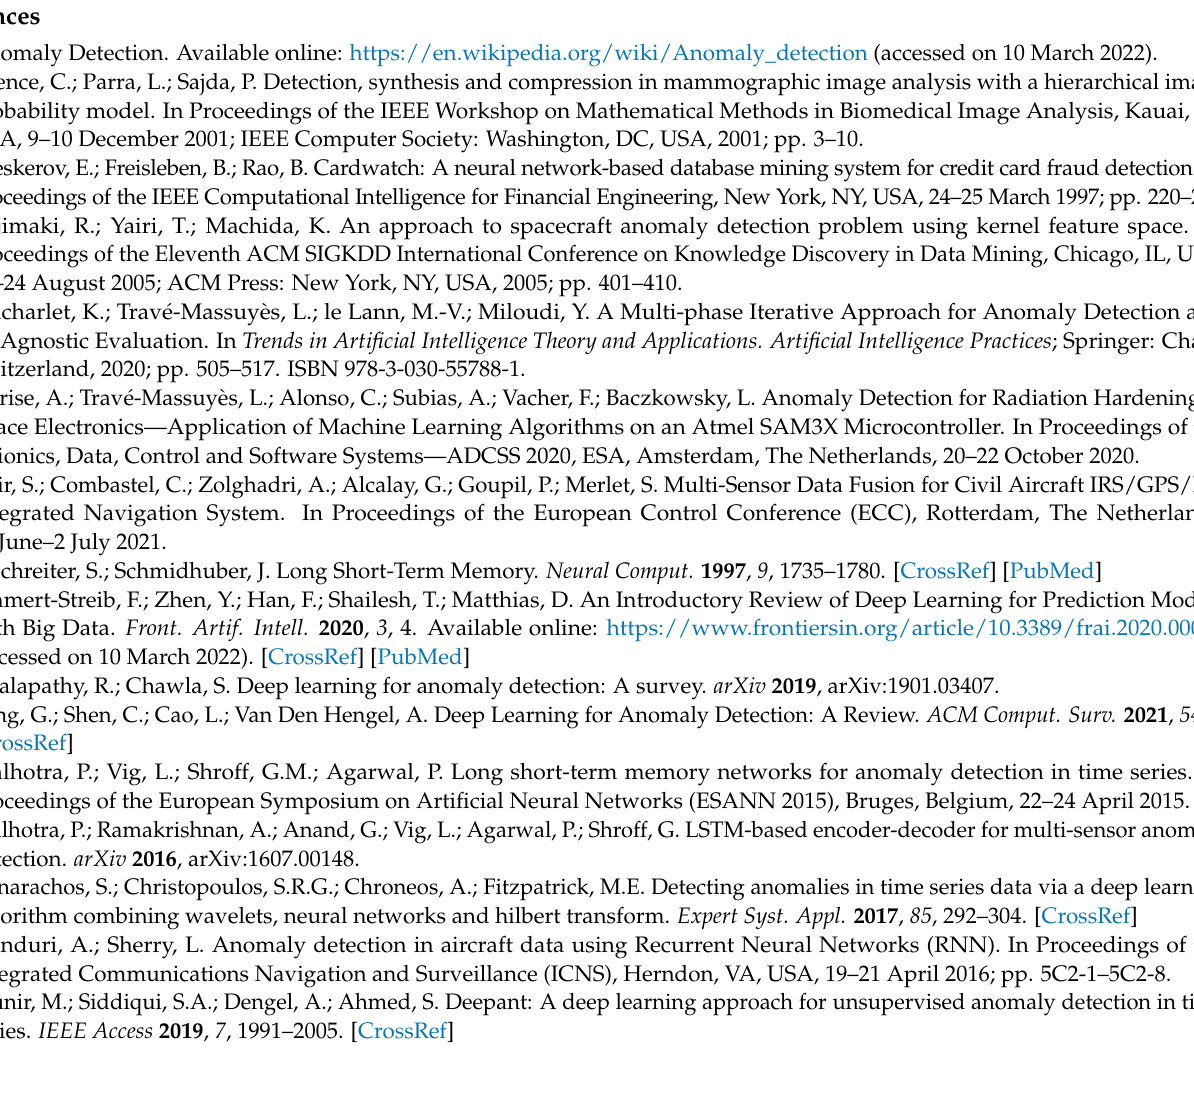
(e.g., Figure 28). NADCA can deal with simultaneous anomalies in different sensors (e.g., Figure 25). Figure 30 shows how NADCA avoids the coupling problem.